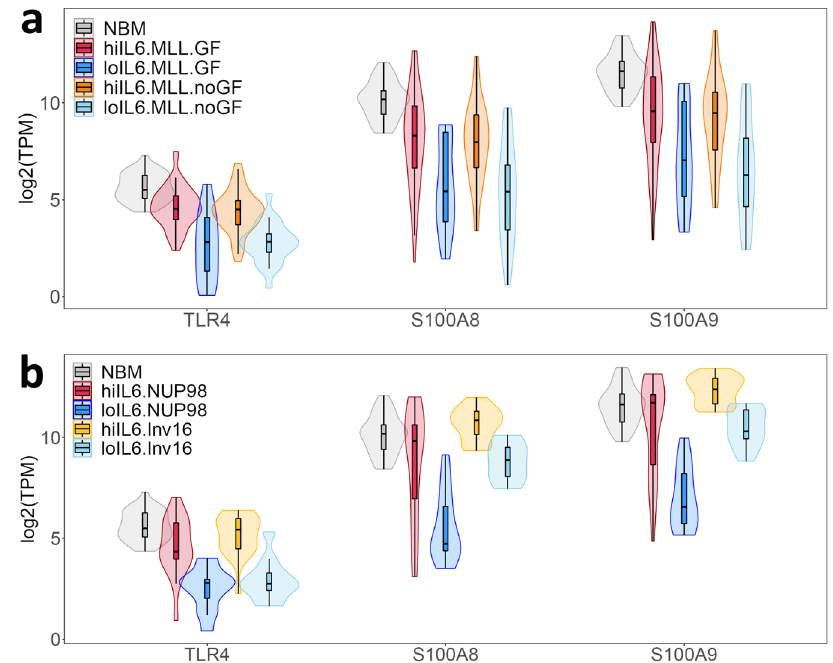
Fig.6|TLR4andS100A8/9areexpressedathigherlevelsinhigh-IL6/Rsamples compared to low-IL6/R,but not NBM.a TLR4 and S100A8/9 expression levels in MLL-rearranged AML with or without RAS/FLT3 mutations (indicated as “ GF ” and ” no-GF ” respectively), and b TLR4 and S100A8/9 expression levels in NUP98 - rearranged and Inv(16) AML with RAS/FLT3 mutations. Numbers of samples per